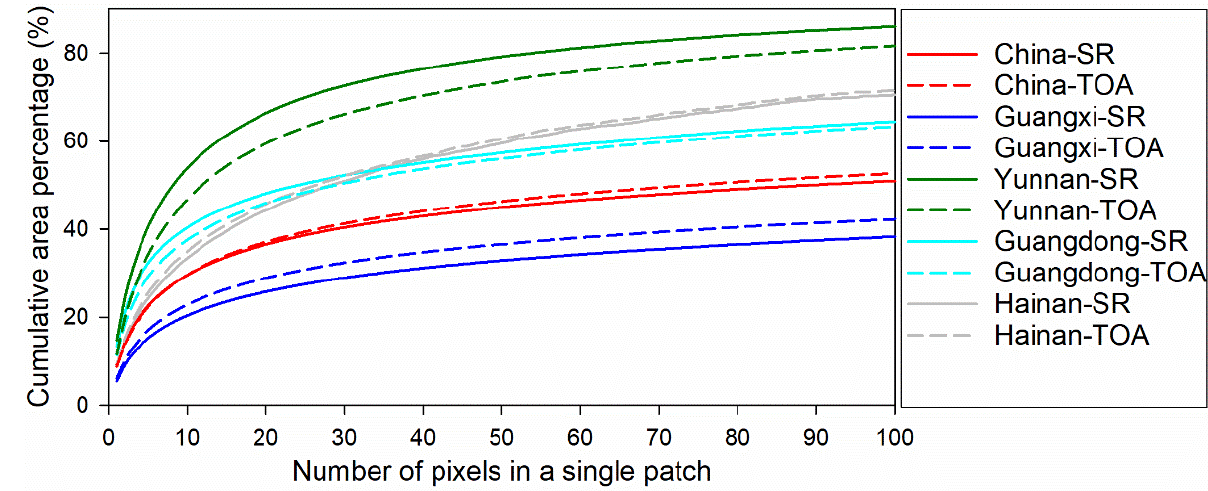
Figure 12. Statistics of patches with different pixel numbers (from 1 to 100) on the sugarcane maps for both SR and TOA data in 2019.